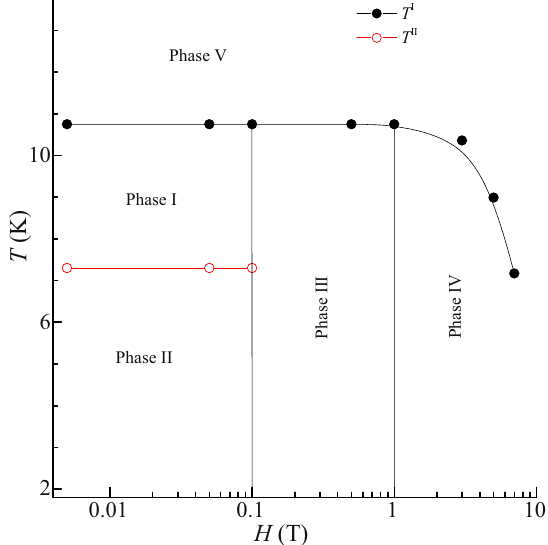
Figure 7. Temperature-Magnetic field phase diagram of